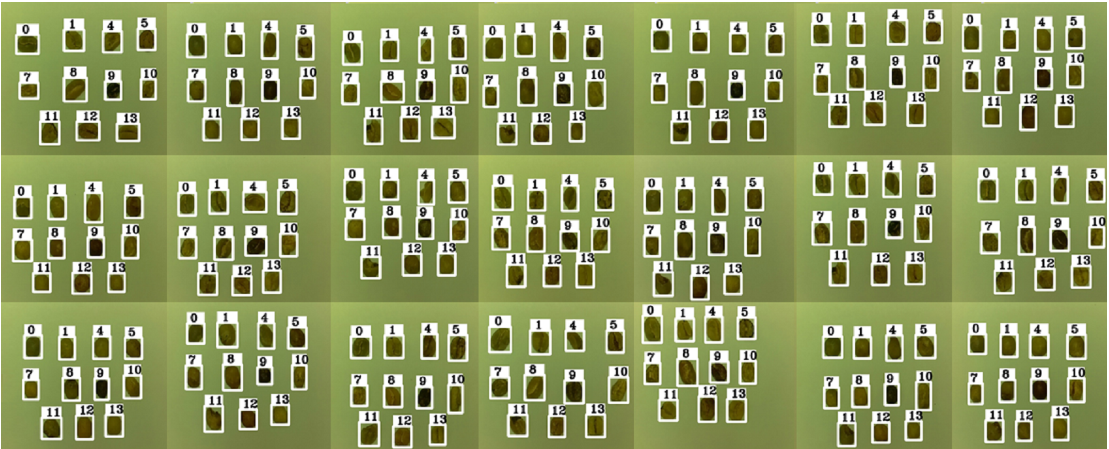
Figure 12. Illustration of some training data set. The white boxes in each image stands for defective beans marked by bean-picking